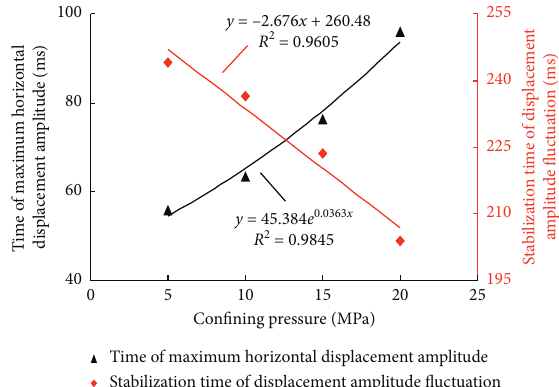
Figure 12: Relation curve between the confining pressure and the time of the maximum horizontal displacement amplitude and stabilization time of displacement amplitude